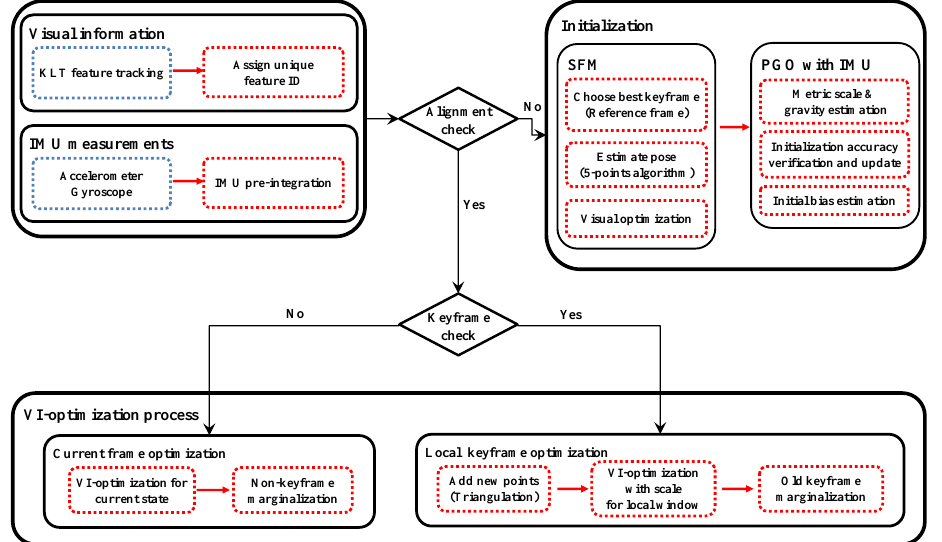
Figure 1. Overview of the proposed system. First, the initialization module computes a vision-only map and tries to determine the global metric scale and gravity. When this bootstrapping is over, the tightly-coupled VIO algorithm continuously estimates the device trajectory. PGO, pose graph optimization.